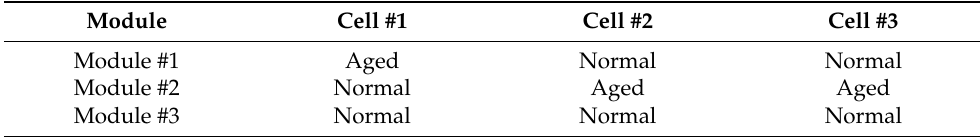
Figure 4. A schematic diagram of the overall experimental setup. Table 5. Battery modules with different cell combinations.